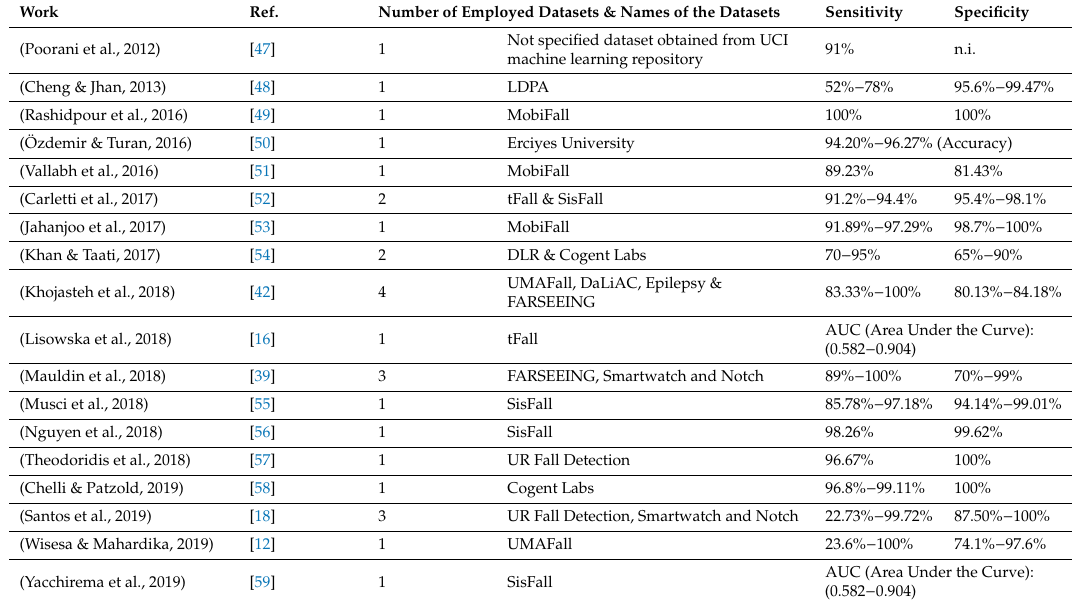
Table 4. Employed datasets and obtained results in other works that propose neural detectors. Work